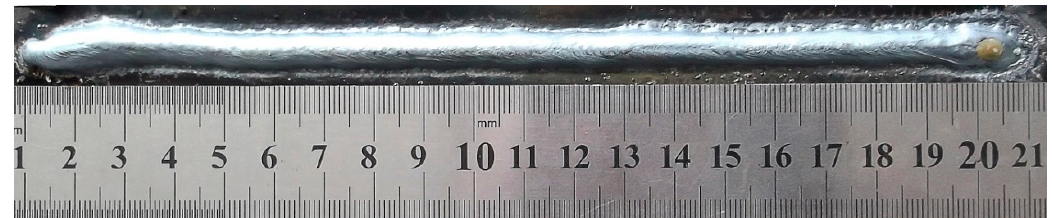
Figure 10. Welding seam of experiment 13.